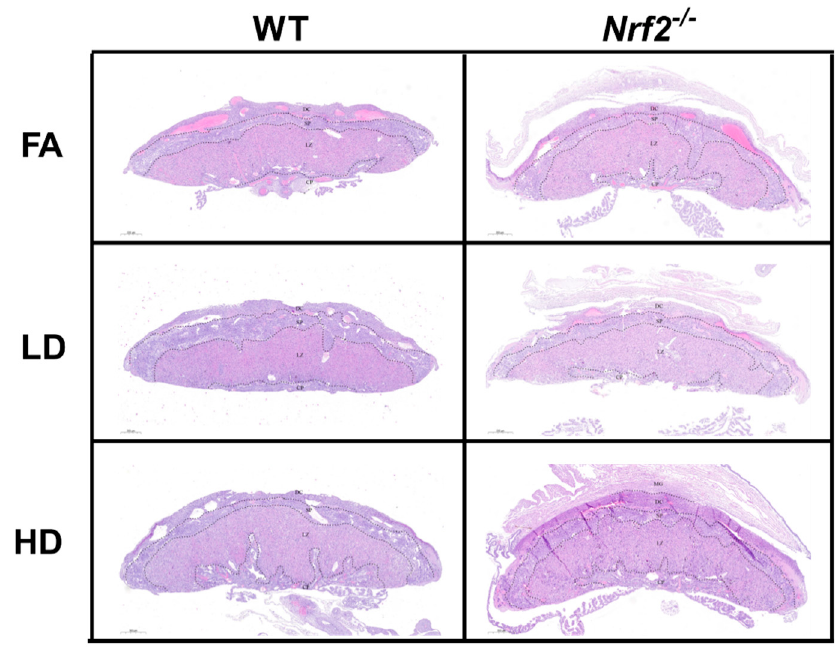
Figure 3. Placental Histology. Representative placental images collected from female offspring depicting wildtype (WT) and Nrf2 − / − mice exposed to filtered air (FA) control, low dose (LD; 100 µg/m 3 ), and high dose (HD; 500 µg/m 3 ). No gross histologic changes were observed across the different groups. Area measurements were made for decidua (DC), spongiotrophoblast (SP), and labyrinth zone (LZ) layers. Sample sizes for placenta from female offspring: WT FA ( n = 8), WT LD ( n = 12), WT HD ( n = 12), Nrf2 − / − FA ( n = 5), Nrf2 − / − LD ( n = 8), Nrf2 − / − HD ( n = 6).